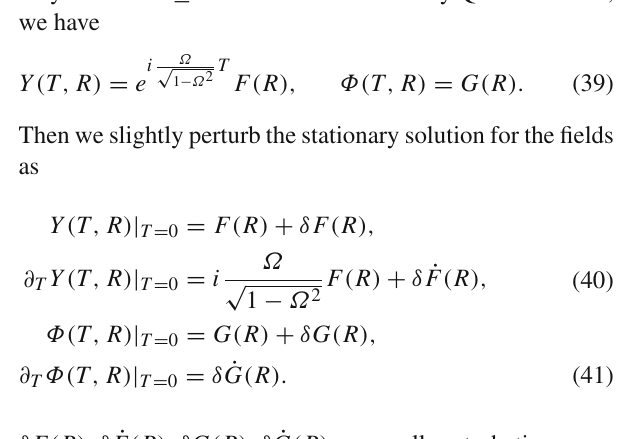
= 0 . 6 with the normalization u 2 ( 0 ) m